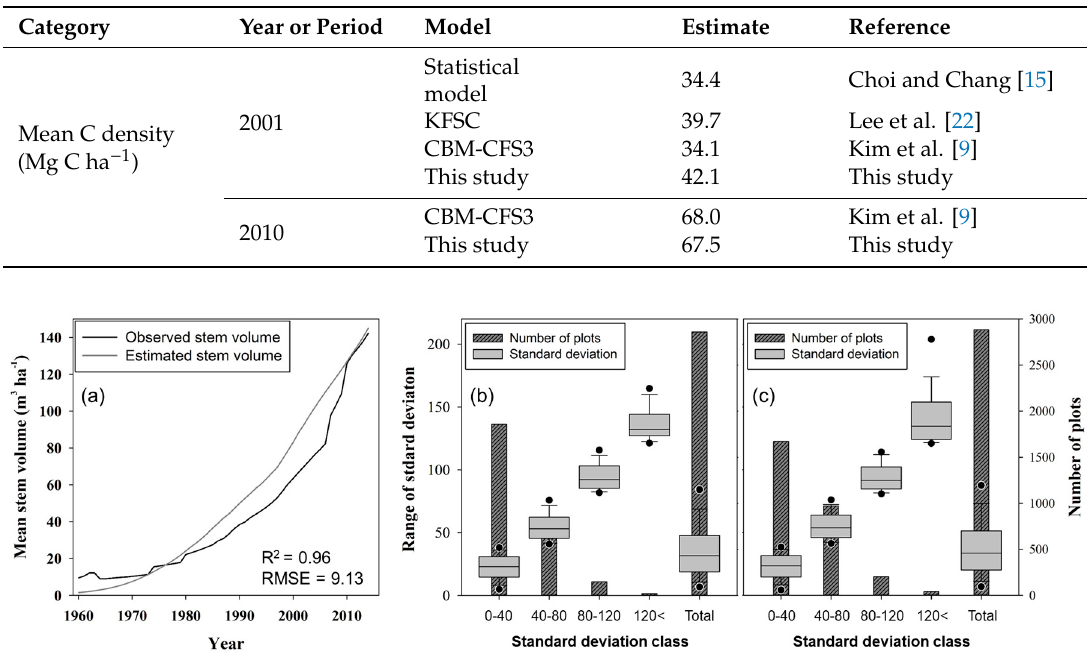
Table 3. Comparison of living biomass carbon (C) densities of South Korean forests estimated in this study with those found in previous studies.